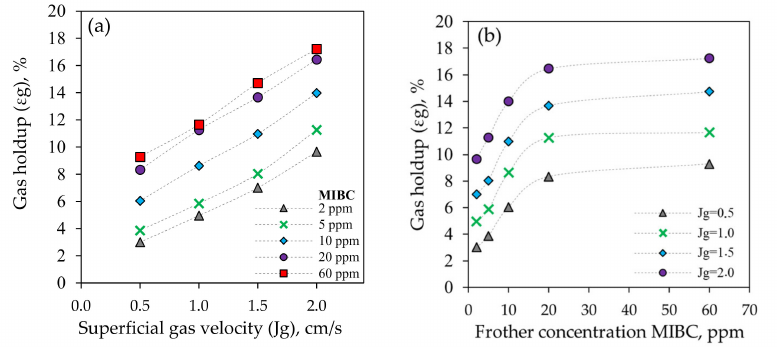
Figure 5. Gas hold-up as a function of ( a ) Superficial gas velocity, and ( b ) MIBC frother